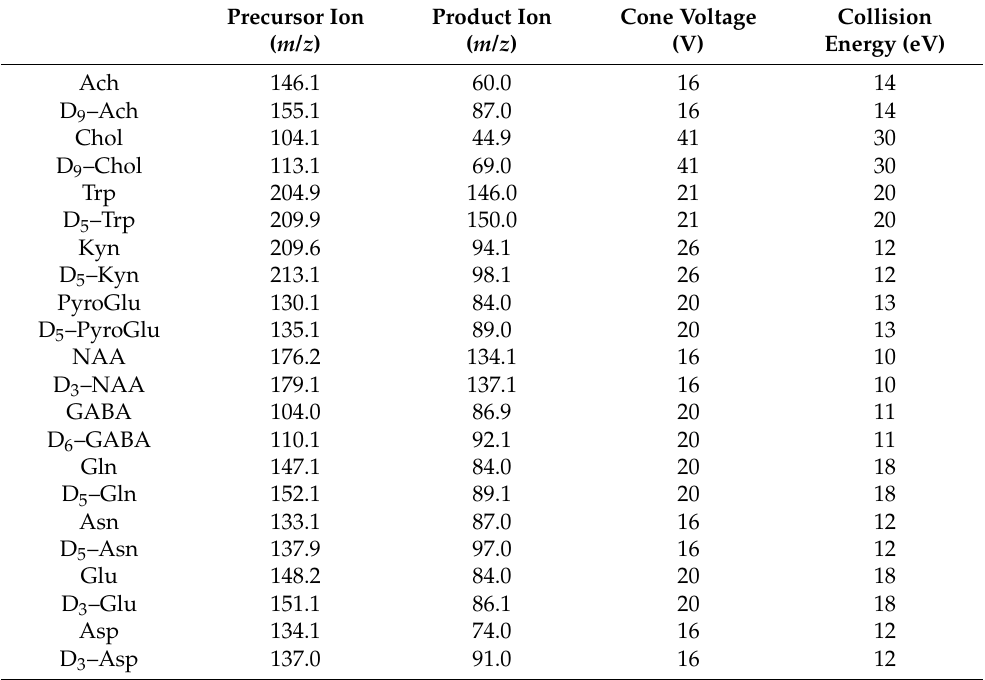
Table 1. Selected MS/MS conditions for analysis of NT, Trp, Kyn and their internal standards. Precursor Ion ( m/z